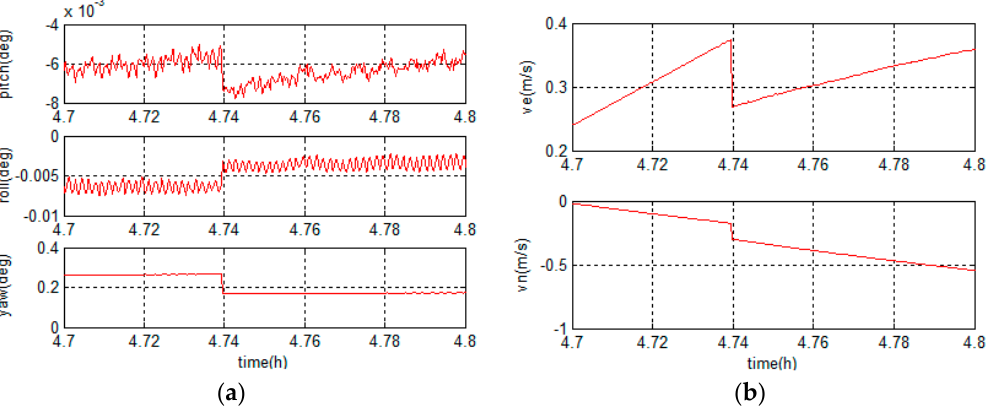
Figure 2. Navigation curves when navigation frame switches: ( a ) attitude curves; and ( b ) velocity curves.